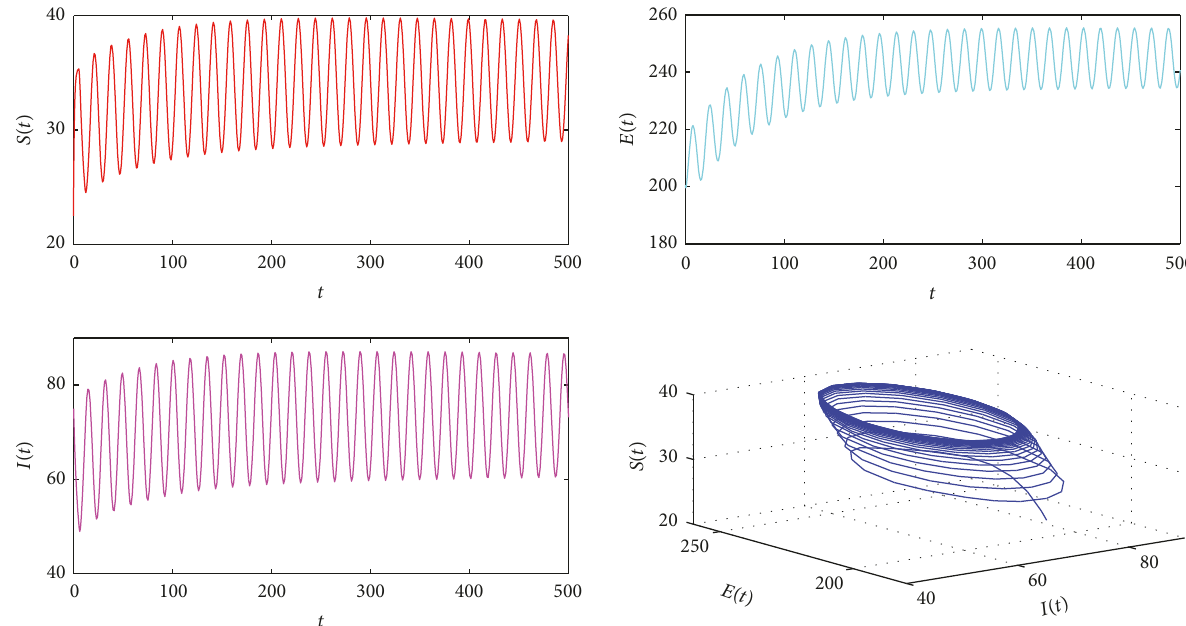
Figure 4: 𝑃 ∗ becomes unstable and a Hopf bifurcation occurs when 𝜏 = 5.485 > 𝜏 0 = 5.1686 with initial values “22, 200, 75.”